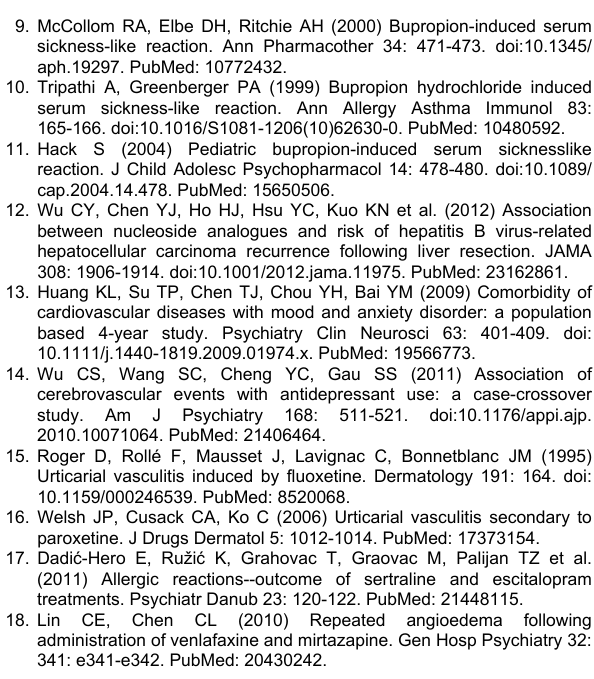
Table S2. Incidence of dermatologist-diagnosed urticaria occurrence in depressive patients within first 4 weeks.